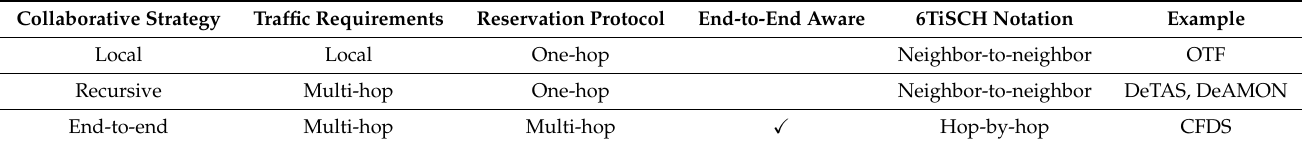
Table 2. Properties of collaborative